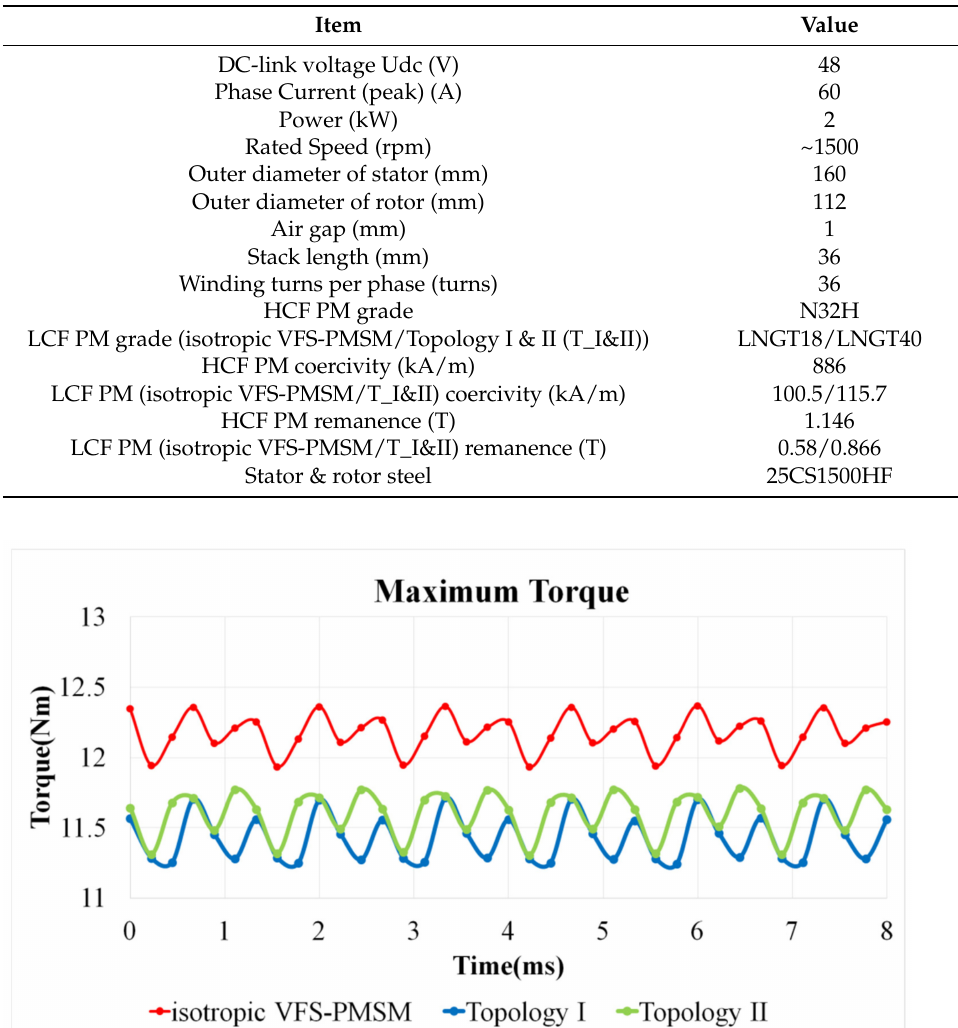
Table 1. Motor parameters and material properties.